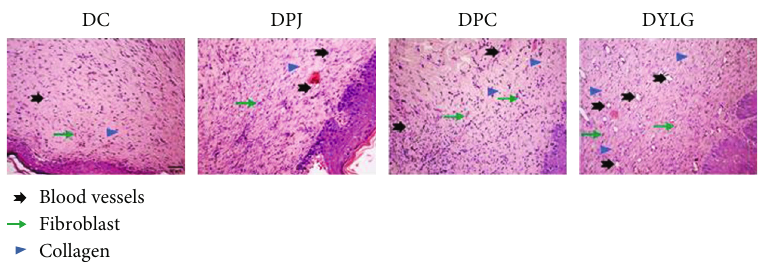
Figure 2: Representative images of haematoxylin and eosin (H&E) staining on the day 21 postwounding in skin wound section of T2DM rats DC, DPJ, DPC, and DYLG groups (20x magni fi cation and scale bar 50 μ